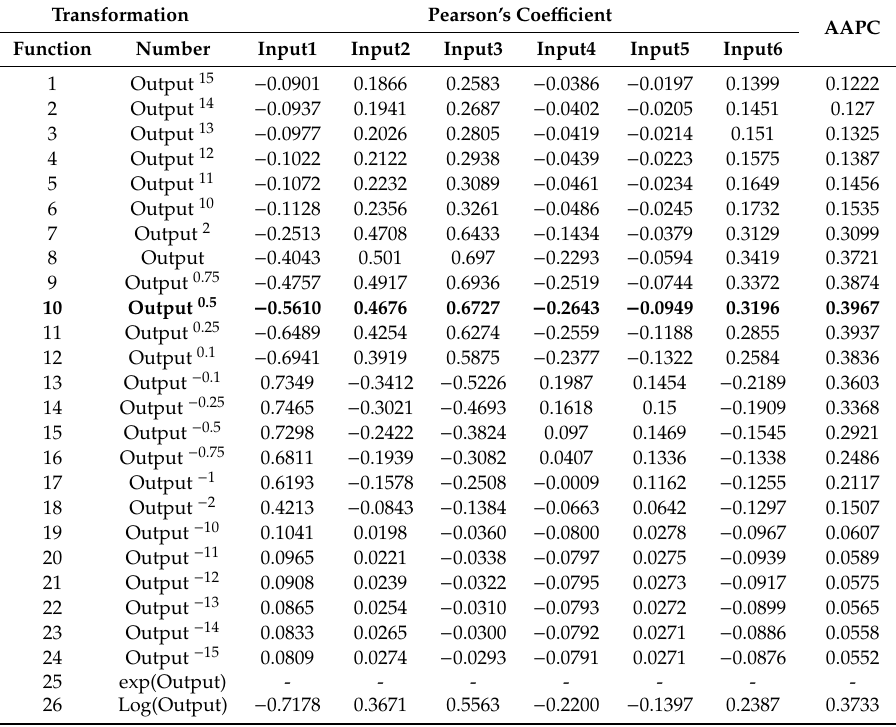
Table 3. Pearson’s coe ffi cient values for di ff erent